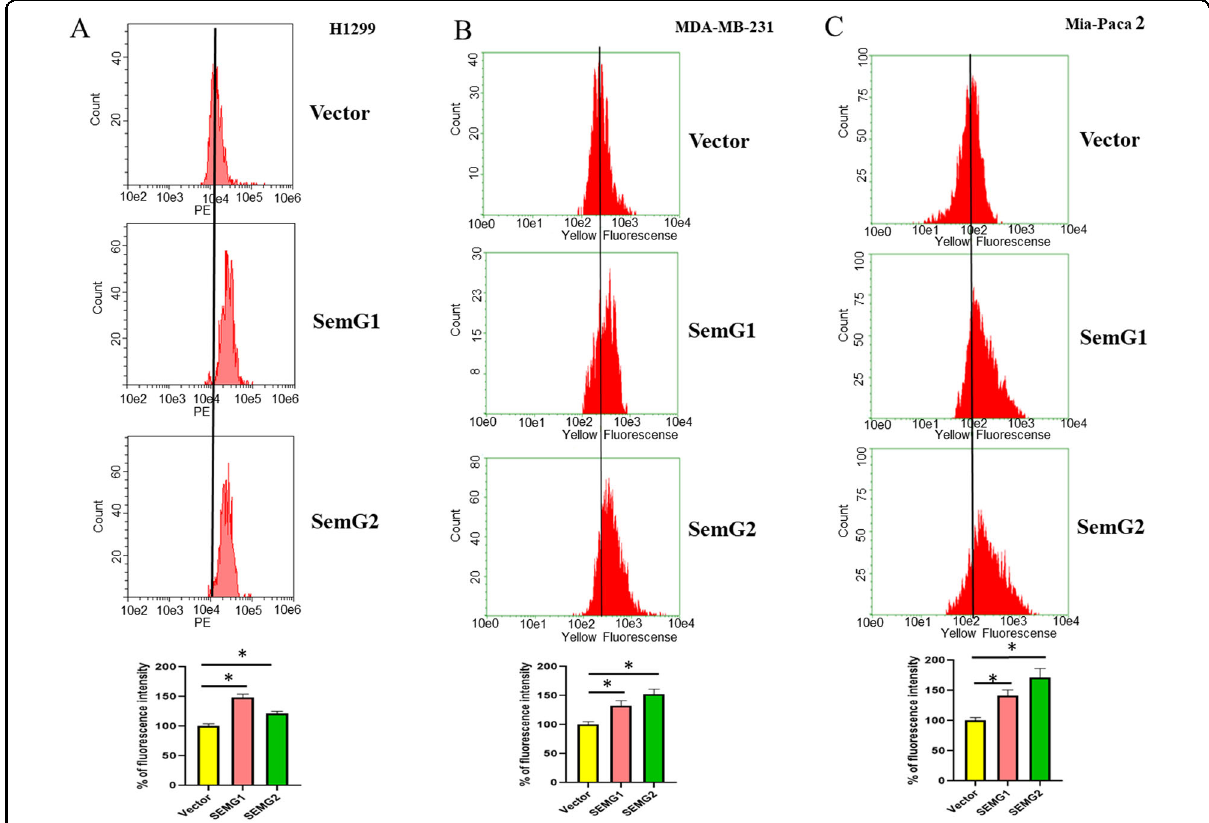
Fig. 5 SEMG1 and SEMG2 increase mitochondrial membrane potential (MMP). The fl ow cytometry of MitoTracker fl uorescence in A H1299, B MDA-MB-231 and C Mia-Paca 2 cells with stable overexpression of SEMG1, SEMG2 or corresponding vehicle. Quanti fi cation was done in triplicates, data are presented as mean ± S.D., * P <